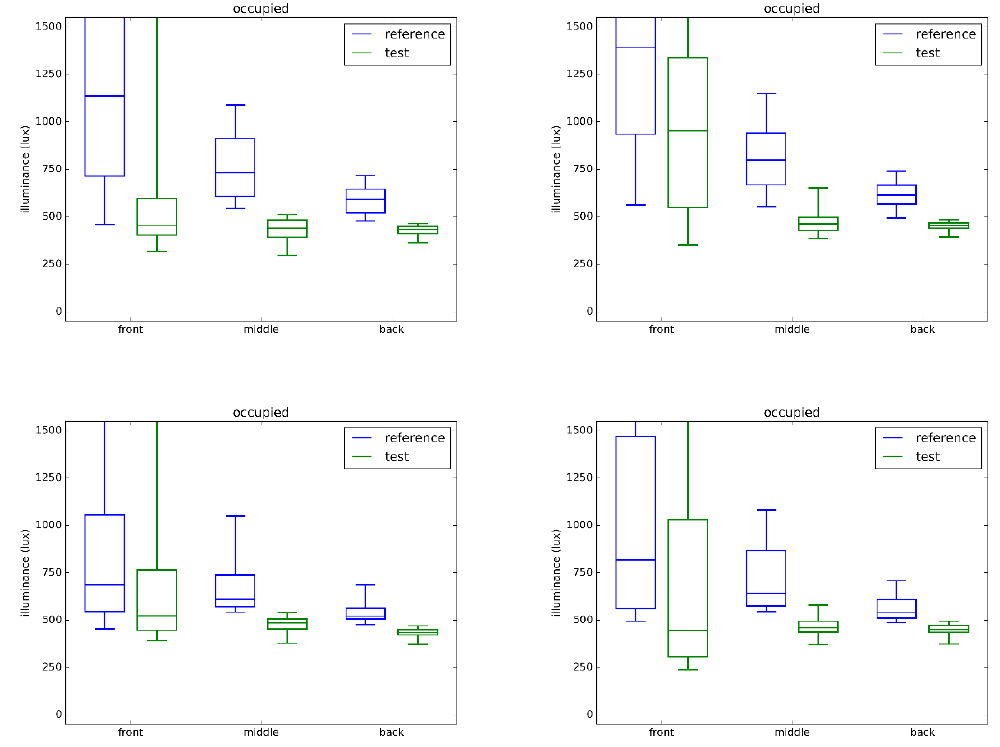
Figure 14. Illuminance levels for Core-S ( top right ), Core-W ( bottom right ), and CorePlus-S ( top left ), CorePlus-W ( bottom left ) for front middle and back rows of workstations during occupied hours.